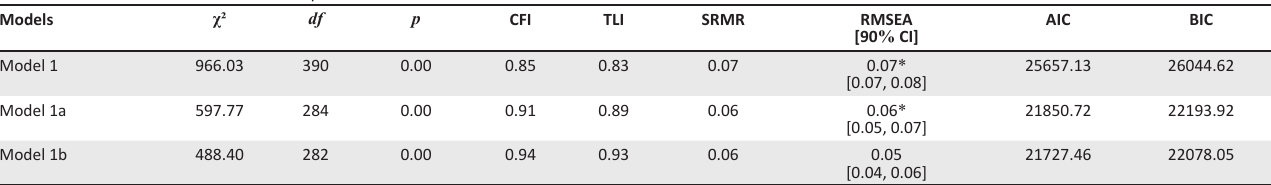
TABLE 2: Model fit statistics for model improvement.